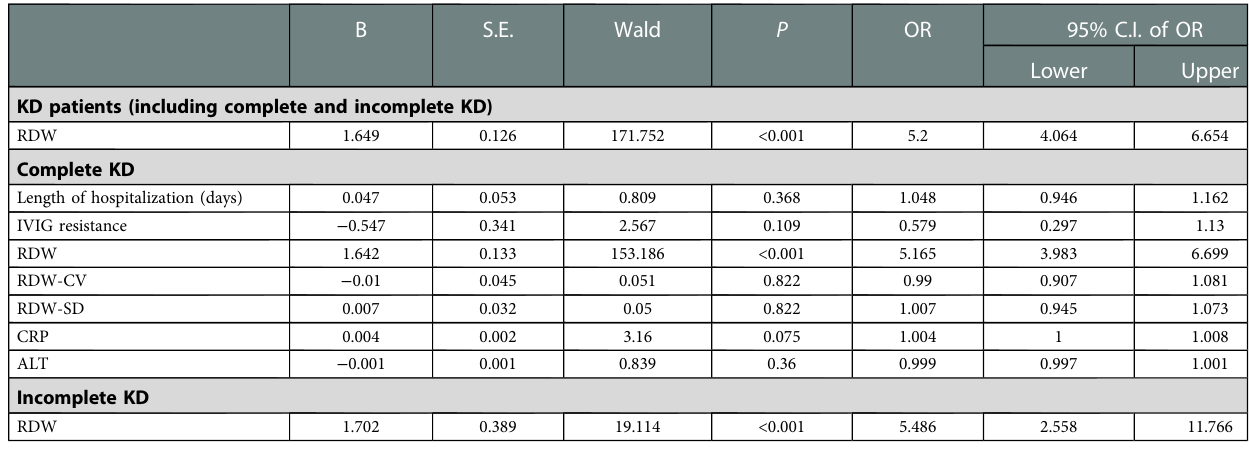
TABLE 2 Multivariate logistic regression analysis for risk factors of CALs in KD patients (including complete and incomplete